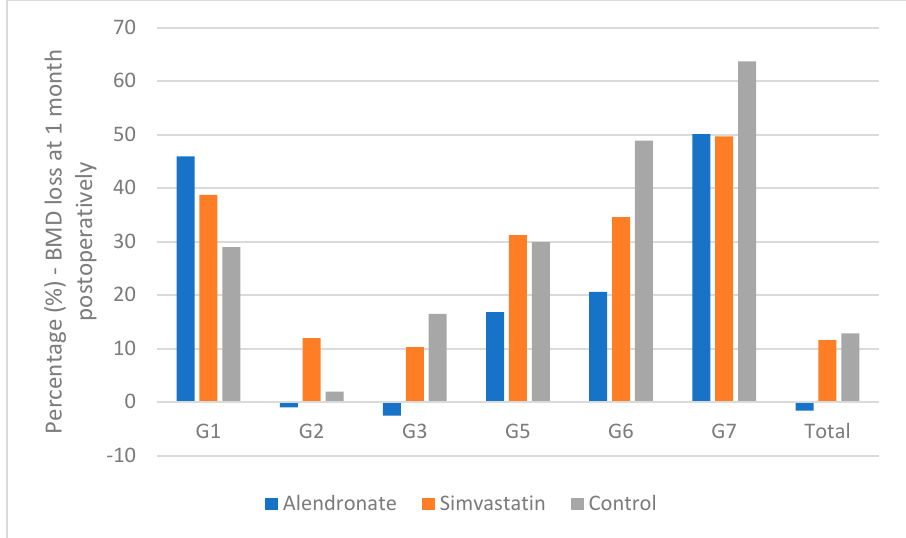
Figure 5. Percentage of BMD change at 1 month postoperatively for each Gruen zone.